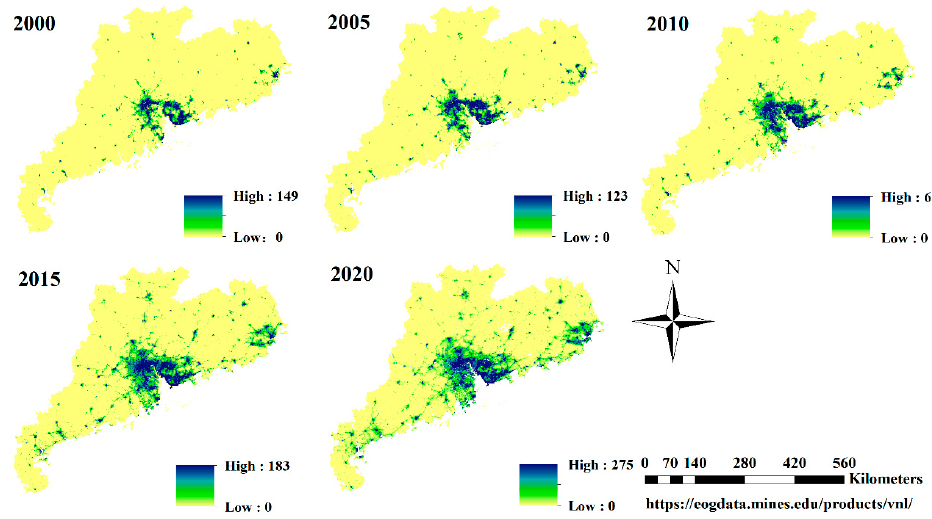
Figure 2. Luminous images of the study area.